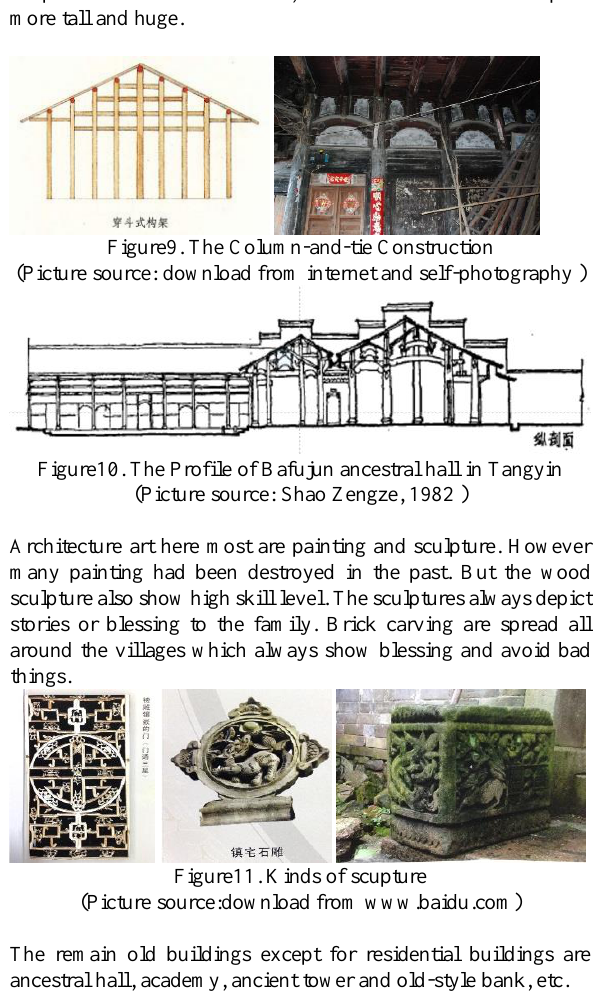
Figure7. Soil Shape Courtyard (Picture source: self-drawing and self-photographing)